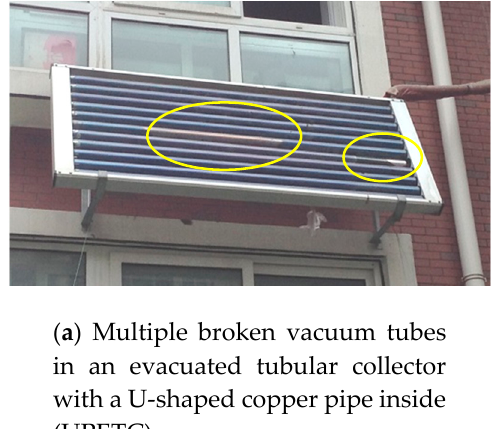
Figure 3. Broken vacuum tubes in evacuated tubular collectors.